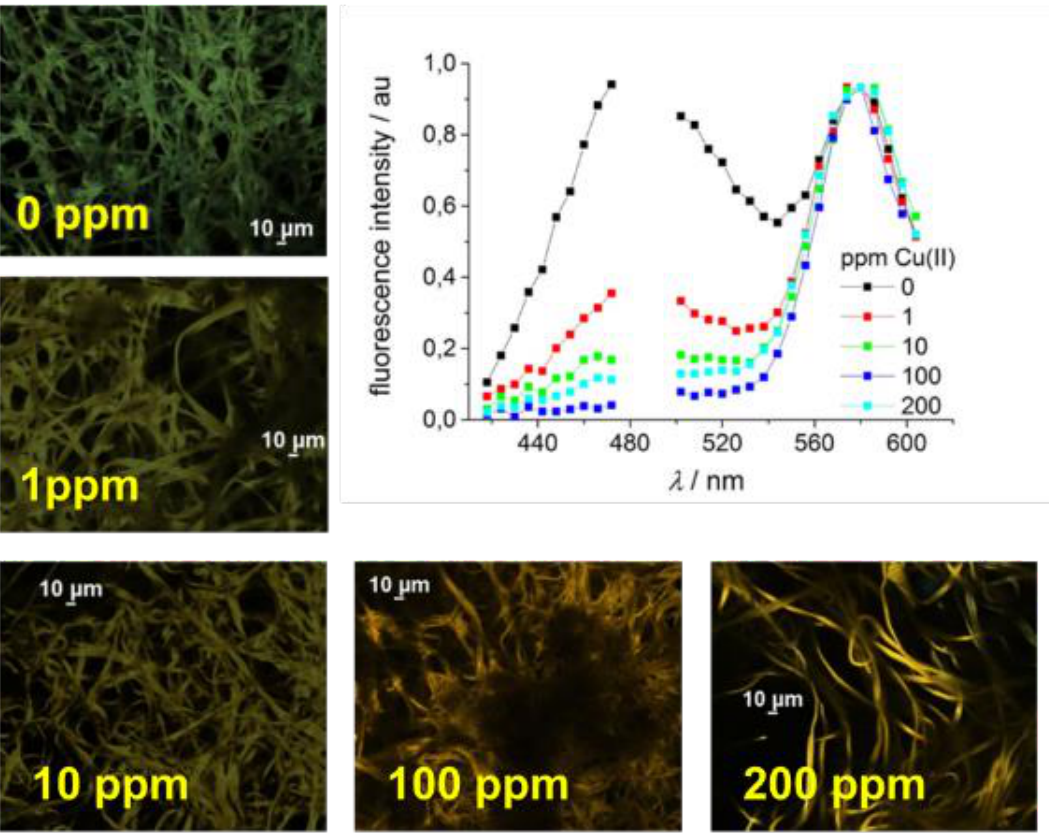
Figure 8. CLSM spectral images and graph with the confocal spectra obtained exciting at 405 nm for the fiber samples treated with different amounts of Cu(II) (due to a dichroic mirror reflecting light centered at 488 nm the spectra is not complete in the 480–500 nm range).